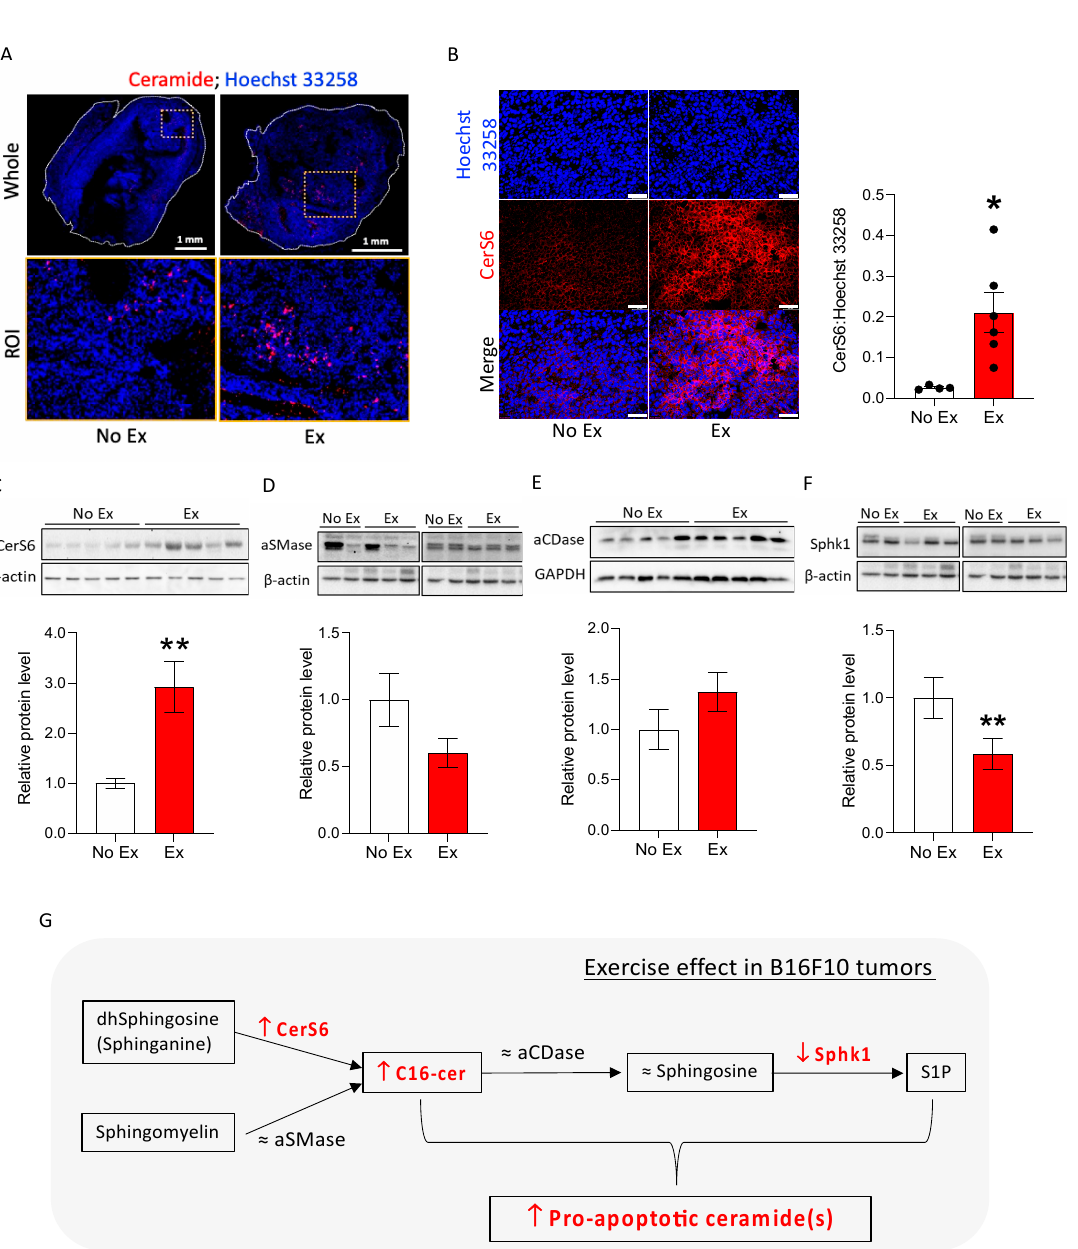
Figure 4. Exercise changes ceramide metabolism enzymes to promote C16-ceramide accumulation in B16F10 tumors. ( A ) Representative immunofluorescent images visualize ceramide (red) and nuclei (blue) in the whole tissue and ROI (region of interest, dotted square in whole) on B16F10 tumor sections. Black dots indicate an individual value of CerS6:Hoechst 33258. ( B ) Representative immunofluorescent images show nuclei (blue) and CerS6 (red). CerS6 was quantified by dividing the area of positive CerS6 staining by the total nucleus area in 2–5 20 × images of each sample to obtain one value per tumor ( n = 2–6). Scale bar = 50 µ m. ( C – F ) Western blots and quantification graphs show relative protein levels of CerS6 ( C ), aCDase ( D ), aSMase ( E ), Sphk1 ( F ). ( G ) Summary diagram showing that exercise altered ceramide metabolism in B16F10 tumors. Data are shown as mean ± SEM. * p < 0.05; ** p < 0.01 vs. No Ex. The uncropped blots are shown in Figure S5.